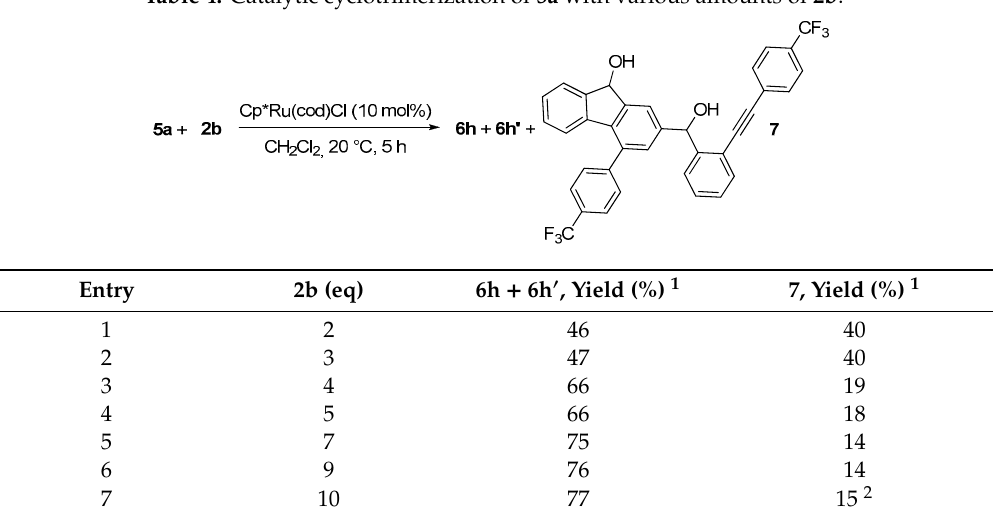
Table 4. Catalytic cyclotrimerization of 5a with various amounts of 2b .